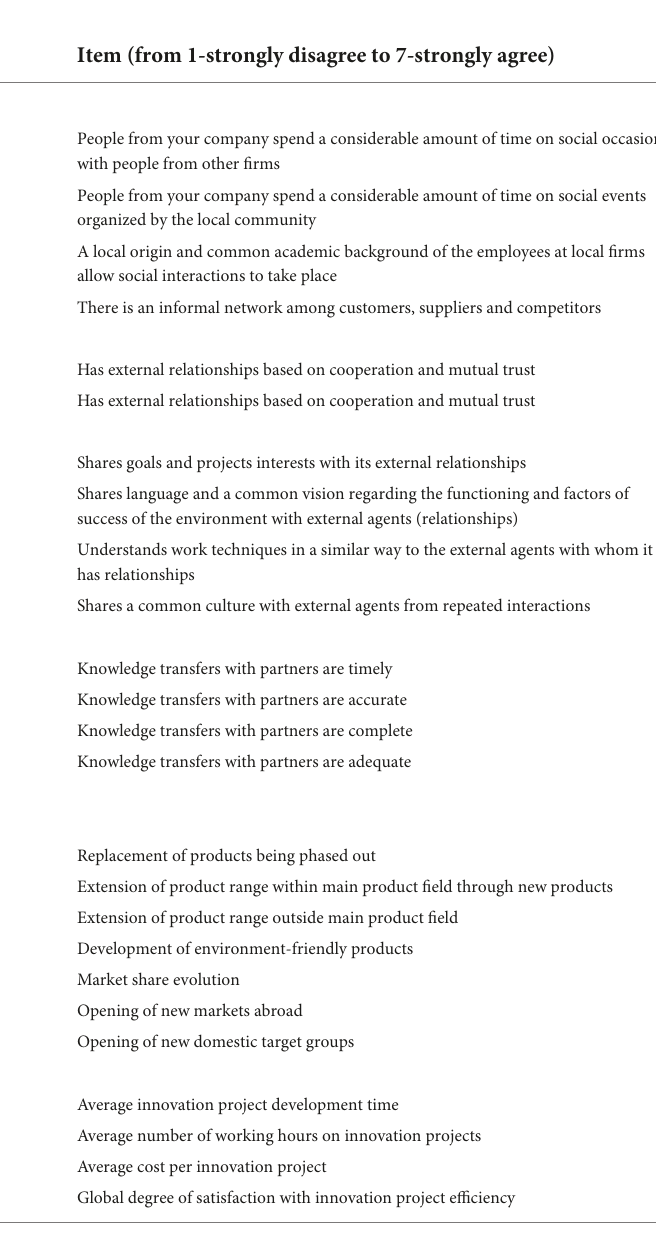
TABLE A1 Research